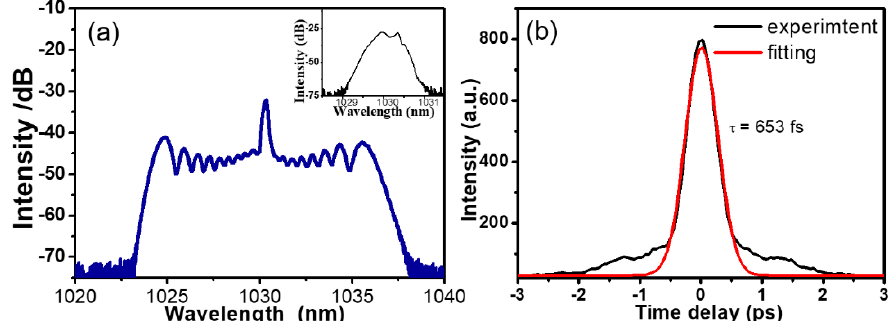
Figure 2. The measured ( a ) spectral intensity and ( b ) autocorrelation of the compressed pulse from the three-stage pre-amplifiers, which were measured after the grating-based compressor. The inset in ( a ) shows the spectral profile of the oscillator.